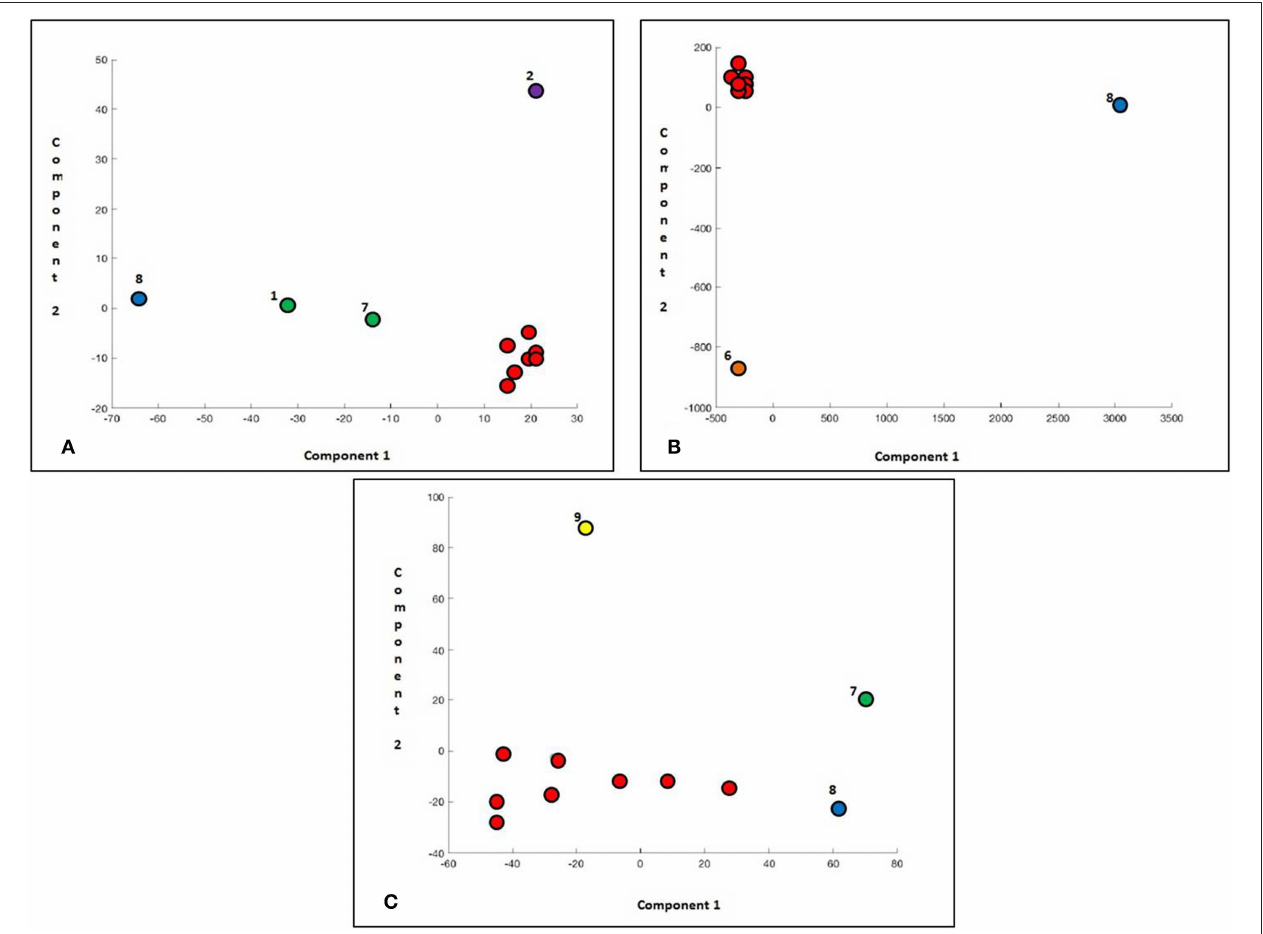
FIGURE 5 | Two-dimensional scatter plot PCA scored for different pathways. (A) Polycomb; (B) WNT; and (C) JAK/STAT. Resistant patients #8 always scored in a PCA different class.